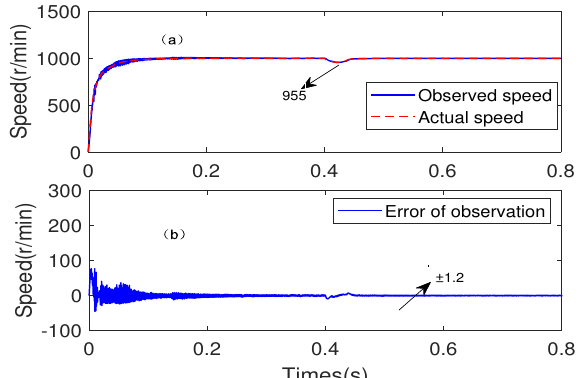
Figure 12. The speed response of VPDPI regulator under 1000 r/min. ( a ) Observed speed and actual speed. ( b ) Estimation error